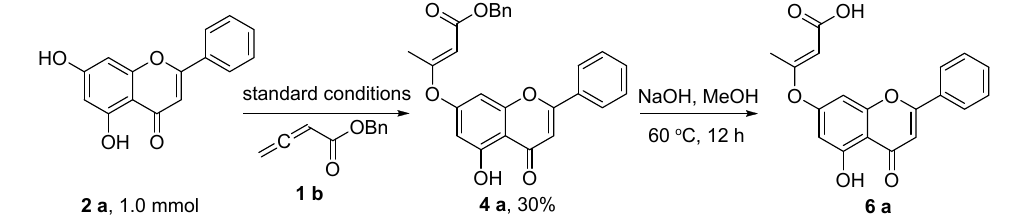
Scheme 1. Synthesis of flavonoidal ether and derivatization.